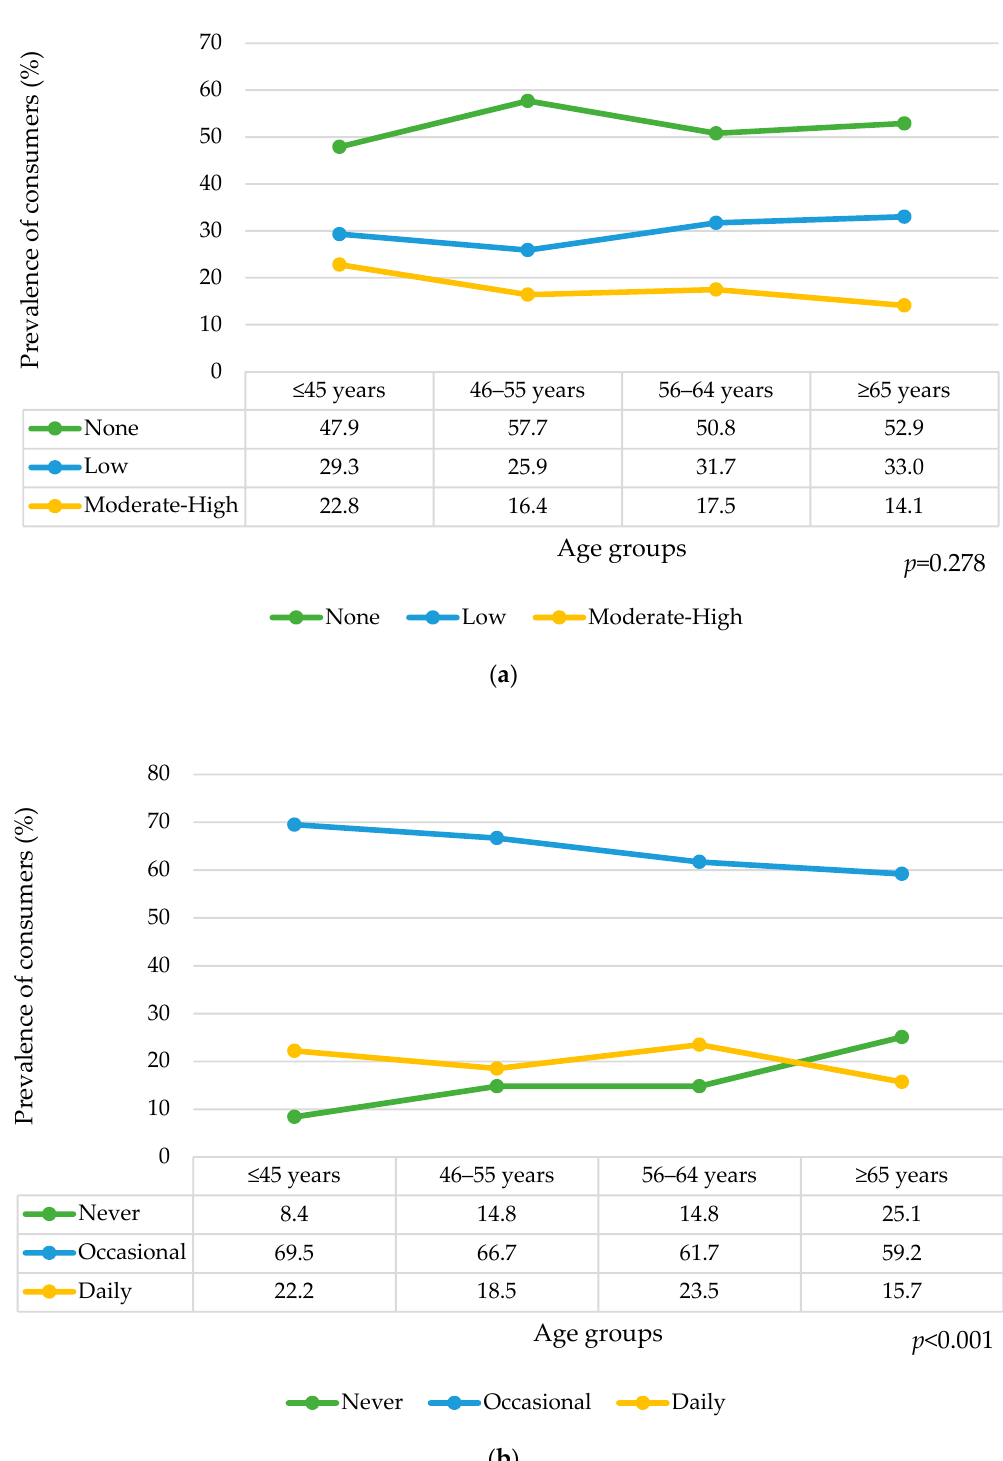
Figure 1. Prevalence of SSBs consumption in the sample stratified by age groups: ( a ) by calorie amount classification; ( b ) by frequency